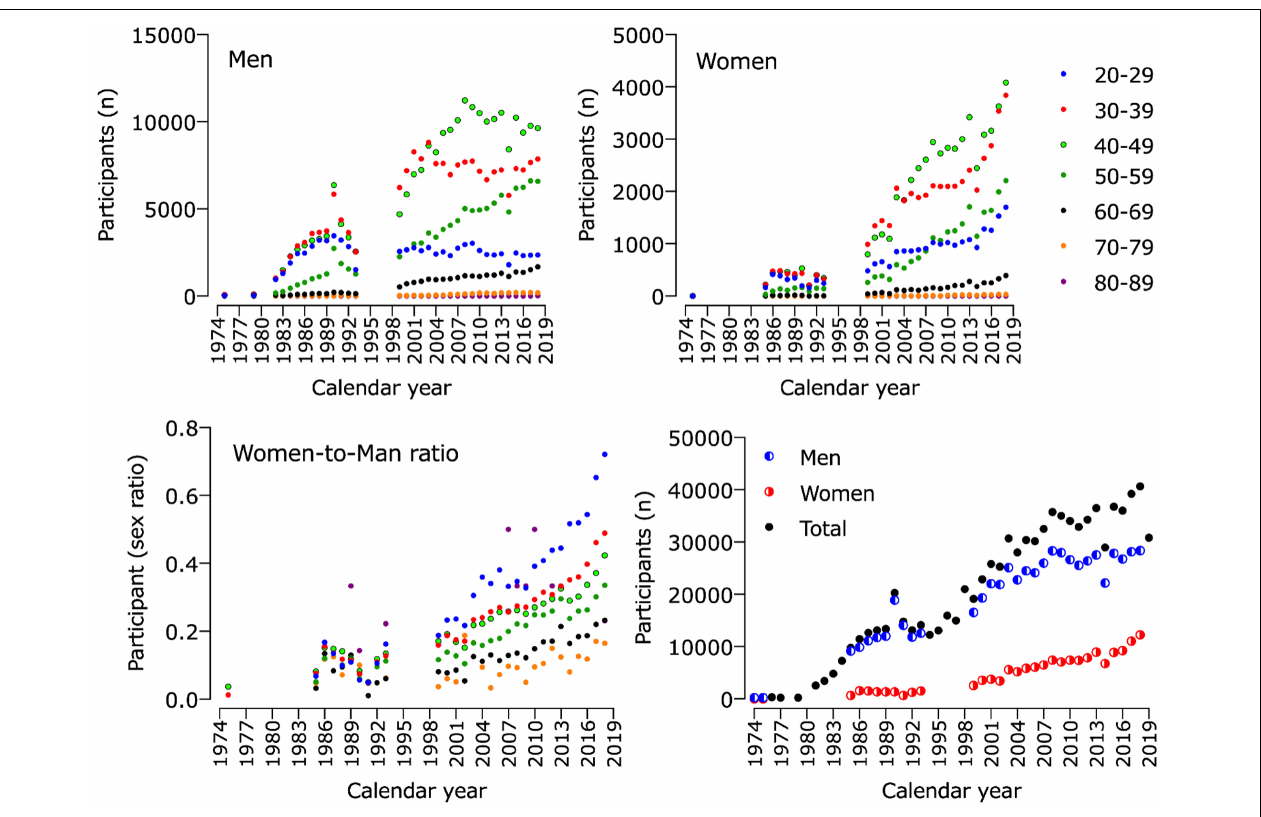
FIGURE 1 | Number of participants in “Berlin Marathon” from 1974 to 2019 by sex and age